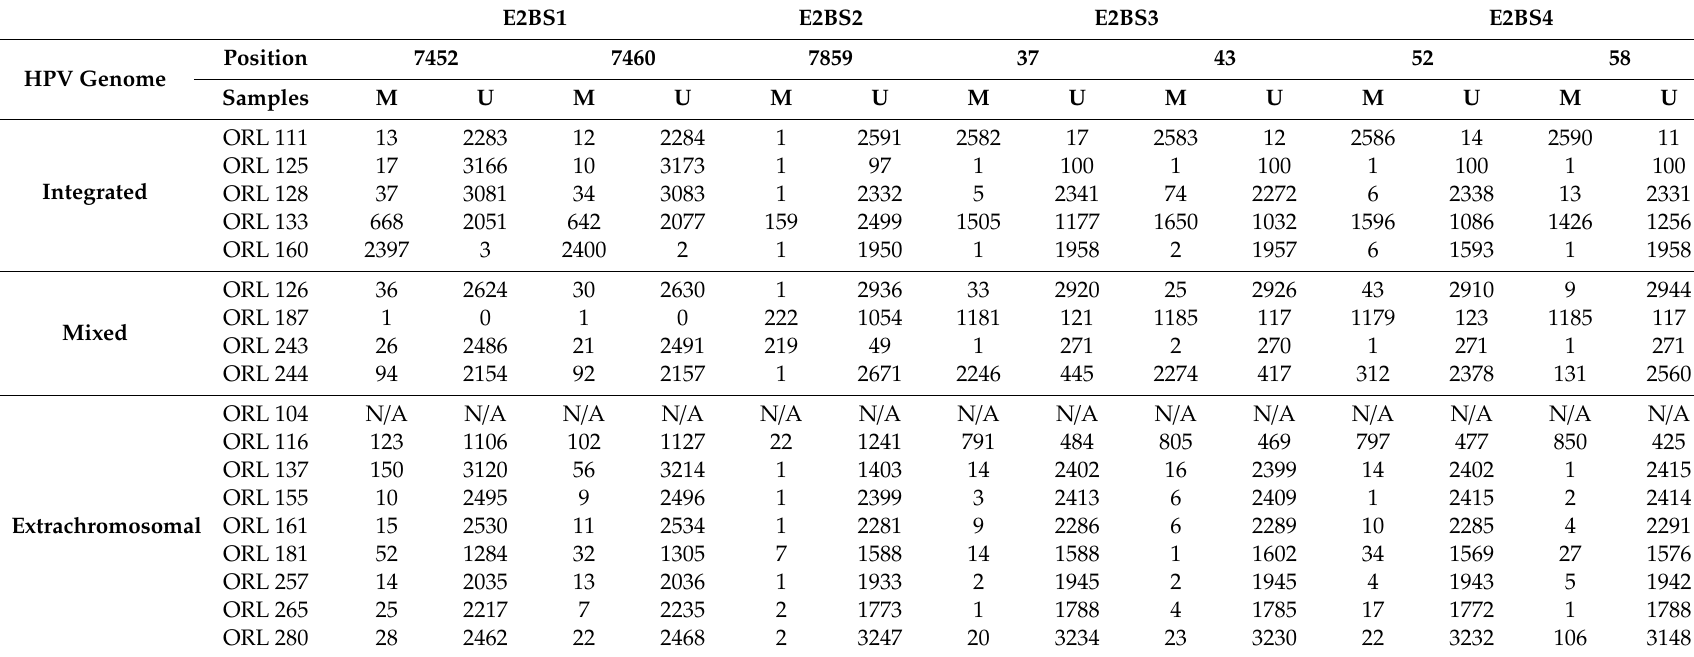
Table 2. Methylation analysis results. Numbers of methylated (M) and unmethylated (U) sequences for each CpG of di ff erent E2BSs. Samples are divided according to their HPV genome status into extrachromosomal, mixed and integrated. Excluded from analysis were sequences of samples ORL187 (CpG 7452 and 7460) and ORL125 (CpG 7859, 37, 43, 52 and 58) due to low number of sequences analyzed ( < 200